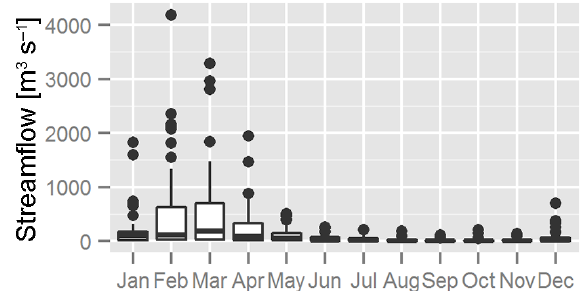
Figure 2. Box plot of monthly streamflow at station